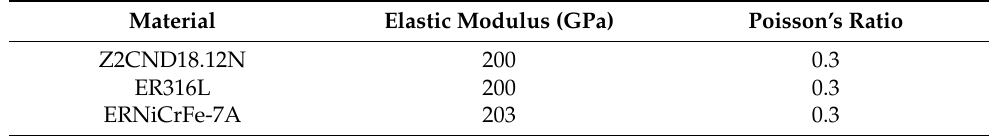
Table 4. Mechanical